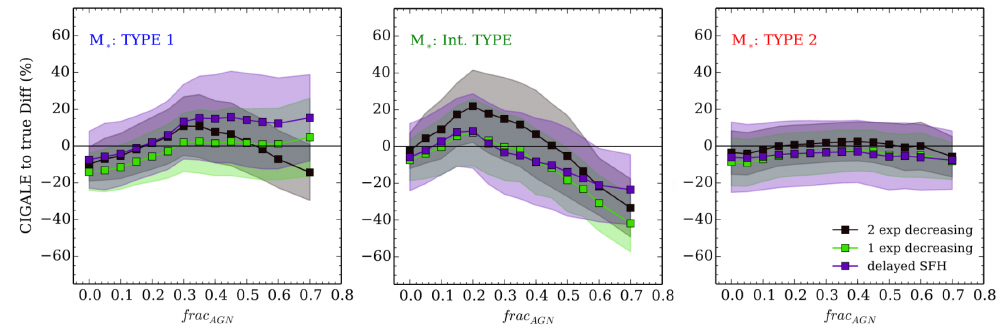
Figure 10. Fractional differences between the stellar mass derived from SED fitting code CIGALE and that used as an input to produce the mock photometry from simulations as a function of the AGN-to-total light fraction in the IR luminosity frac AGN (adopted from Figure 6 in [185], reproduced with permission © ESO). The galaxy masses are built up through star formation models as keyed to the lower right. See the original paper for